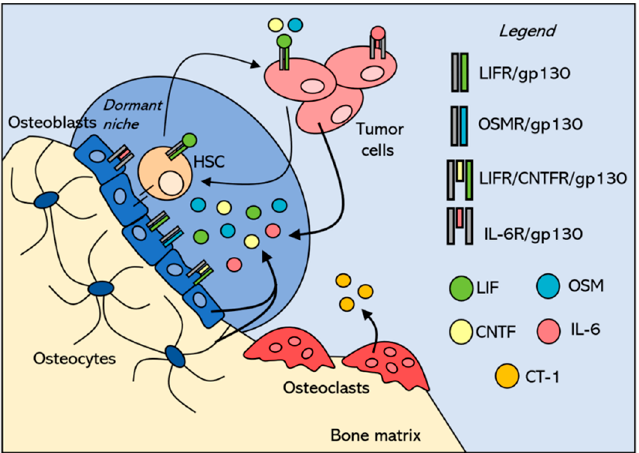
Figure 2. Bone-disseminated tumor cells compete with hematopoietic stem cells (HSCs) in the endosteal niche, where they encounter pro-dormancy cytokines in the microenvironment. Tumor cells that disseminate into the bone marrow are proposed to compete with HSCs for the endosteal niche, which maintains dormancy through cell–cell interactions and secreted factors, including the gp130 cytokines. These cytokines normally send pro-dormancy signals to the HSCs to maintain their quiescence, and when tumor cells compete for this niche, are likely to encounter the same cytokine milieu. Both HSCs and breast cancer cells express LIFR, although LIFR is markedly down-regulated in more aggressive breast cancer cells This suggests that both HSCs and breast cancer cells are capable of responding to LIF, OSM, and CNTF secreted within the bone marrow microenvironment. The sources of these cytokines in the pro-dormancy niche are bone-lining osteoblasts and osteocytes embedded within the bone matrix. Osteoclasts do not express most of the gp130 cytokines, but do express CT-1, which can also bind to LIFR. It is unclear how this might contribute to the pro-dormancy niche along the quiescent osteoblast-lined surface. LIF = leukemia inhibitory factor, OSM = oncostatin M, CNTF = ciliary neurotrophic factor, CT-1 = cardiotrophin-1, IL-6 = interleukin-6, gp130 = glycoprotein130 co-receptor, LIFR = leukemia inhibitory factor (LIF) receptor, OSMR = oncostatin M (OSM) receptor, CNTFR = ciliary neurotrophic factor (CNTF) receptor, and IL-6R = interleukin-6 (IL-6) receptor.